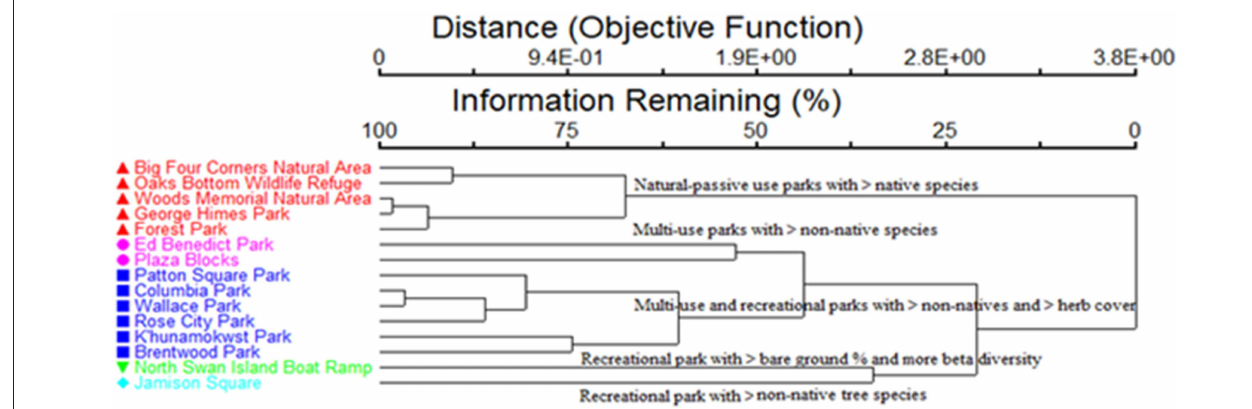
FIGURE 5 | Hierarchical cluster analysis for the urban parks in species space.